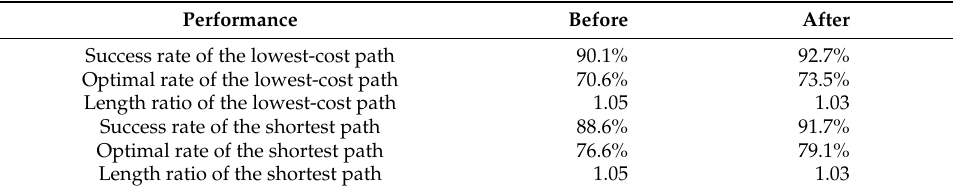
Table 4. Effect of avoiding redundant triangular